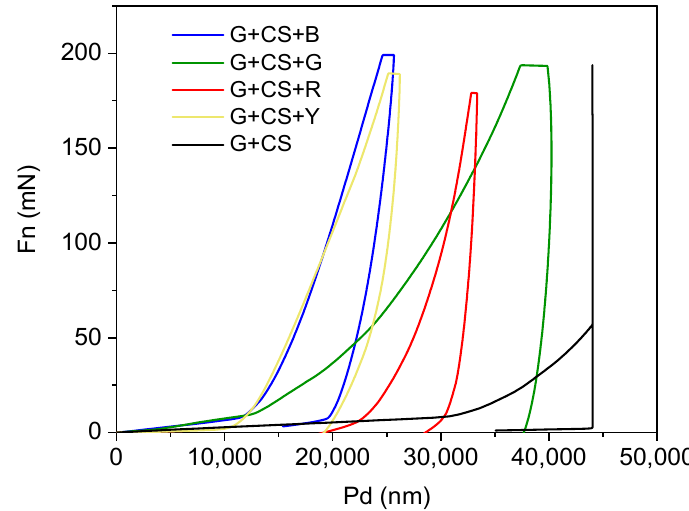
Figure 7. Nanoindentation curve of edible films plotted against force vs. displacement. The G+CS+R film is indicated by the red line, the G+CS+B film is indicated by the blue line, the G+CS+G film is indicated by the green line, the G+CS+Y film is indicated by the yellow line, and the simple G+CS film is indicated by black line.